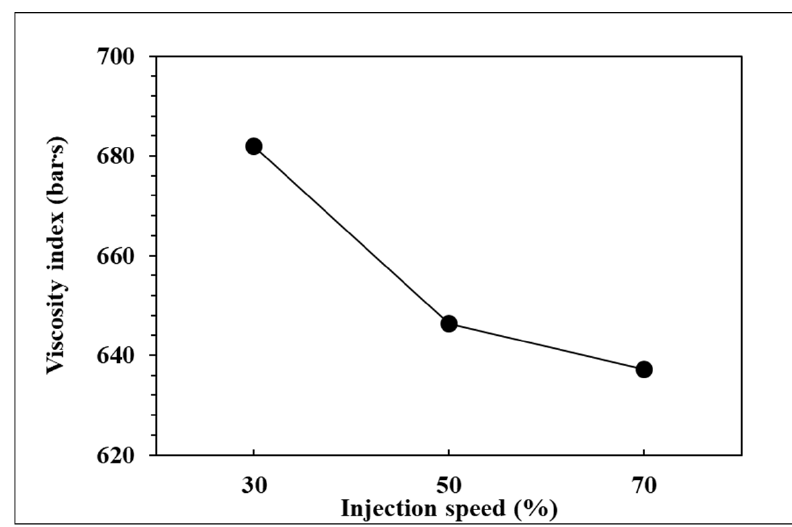
Figure 13. Relationship between viscosity index and injection speed .